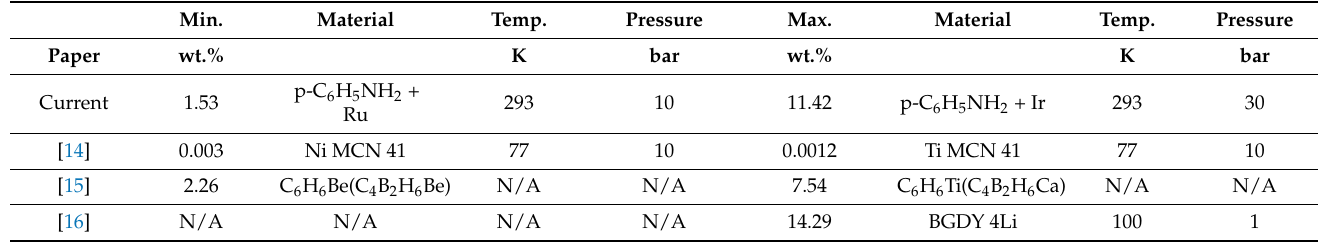
Table 2. Comparison of the obtained results and those reported in the